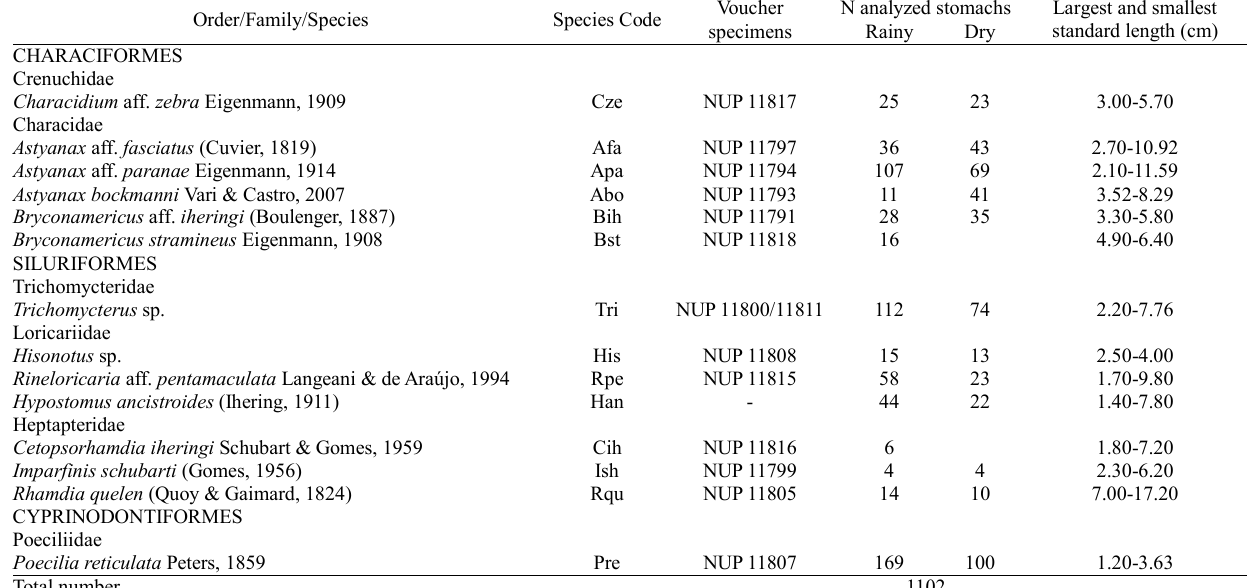
Table 2. Number of stomachs analyzed, for each fish species from Itiz stream, Ivaí River basin, Paraná State, Brazil.